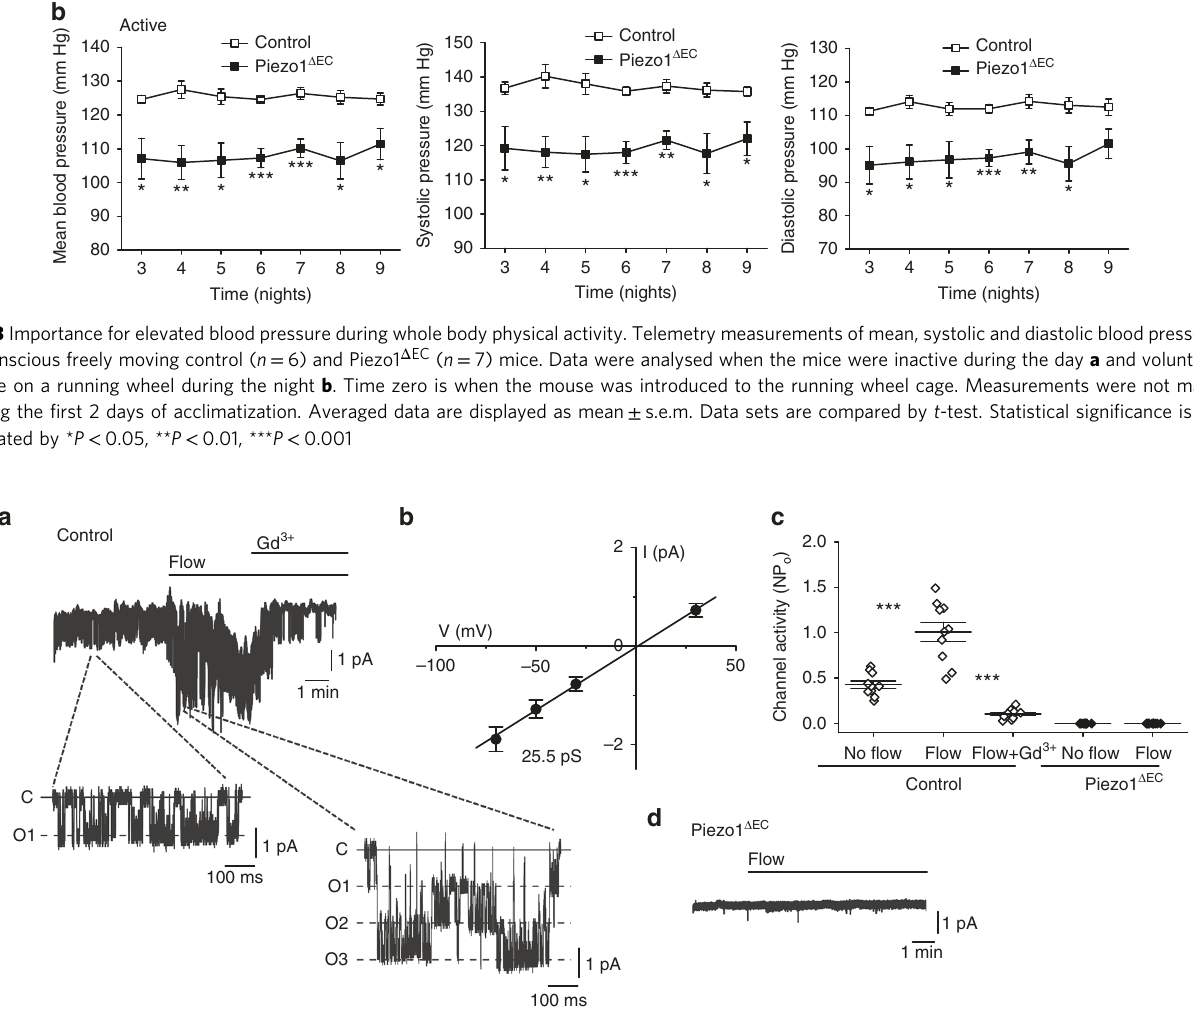
Fig. 4 Piezo1 channels are fl ow sensors in endothelium of mesenteric resistance artery. Data are for ionic current recordings from outside-out patches excised from freshly isolated endothelium of second-order mesenteric arteries. a Example recording at − 70 mV. Two sections are expanded to clarify unitary current events (C: channel closed) (O: 1, 2 or 3 simultaneous channel openings). The patch was placed at the outlet of a capillary from which fl owed ionic solution at 20 μ l s − 1 . Gadolinium ion (Gd 3+ , 10 μ M). b Mean unitary current amplitudes for channels activated by fl ow as in a ( n = 10). c Mean channel activity (NP o : number × probability of opening) for experiments of the type exempli fi ed in a for no fl ow and fl ow conditions and the two genotypes (Control and Piezo1 Δ EC ). Individual data points for each independent experiment are shown as symbols , superimposed on which are the mean ± s.e.m. values ( n = 10 for each group). d Example original trace for a patch from Piezo1 Δ EC endothelium exposed to 20 μ l s − 1 fl ow. Averaged data are displayed as mean ± s.e.m. Data sets are compared by t -test. Statistical signi fi cance is indicated by *** P < 0.001